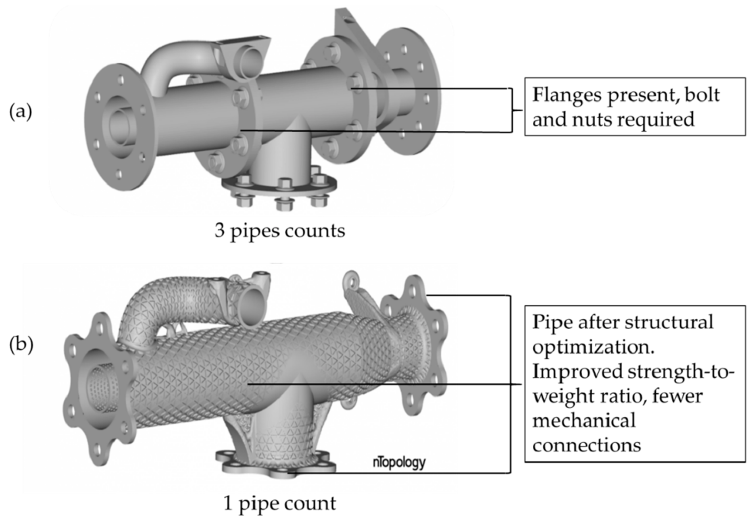
Figure 8. Case studies including. ( a ) classical assembly of pipes and ( b ) redesigned pipe assembly as consolidated a pipe assembly with conformal ribbing. Reproduced from [44] with permission from nTolology.